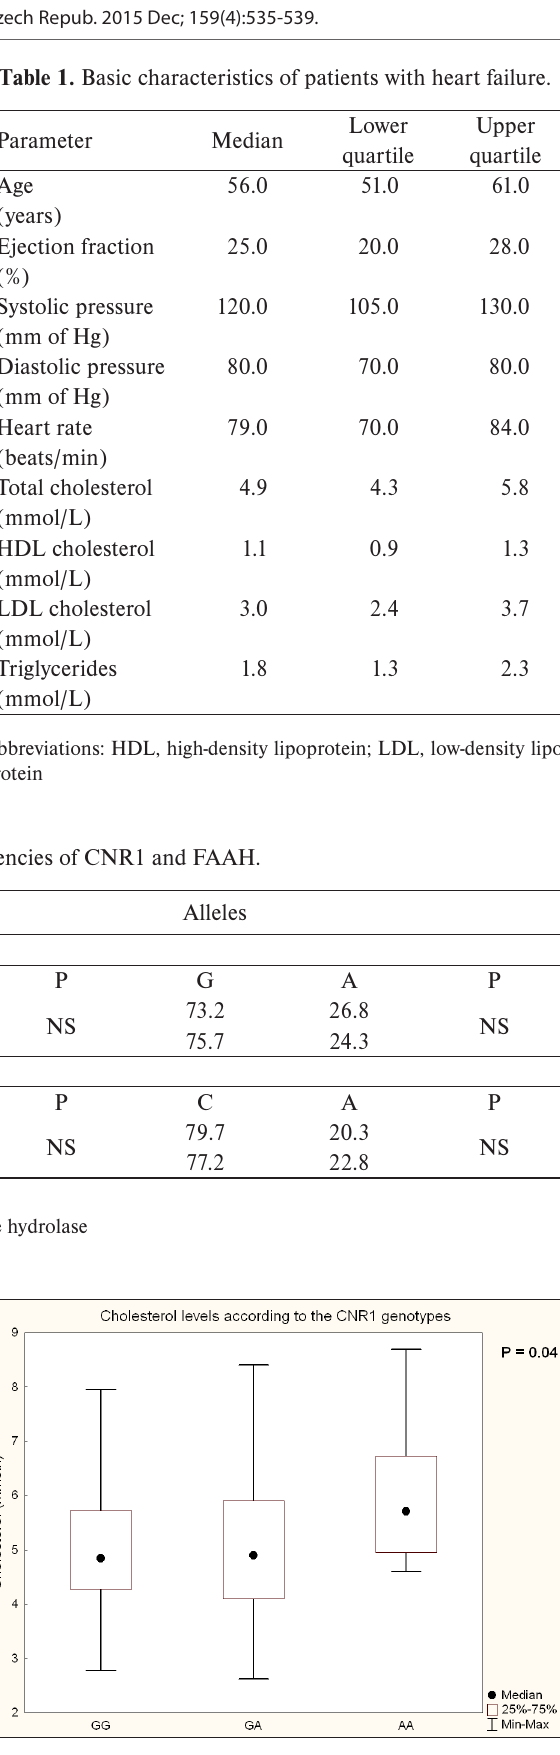
Fig. 1. Cholesterol levels according to the CNR1